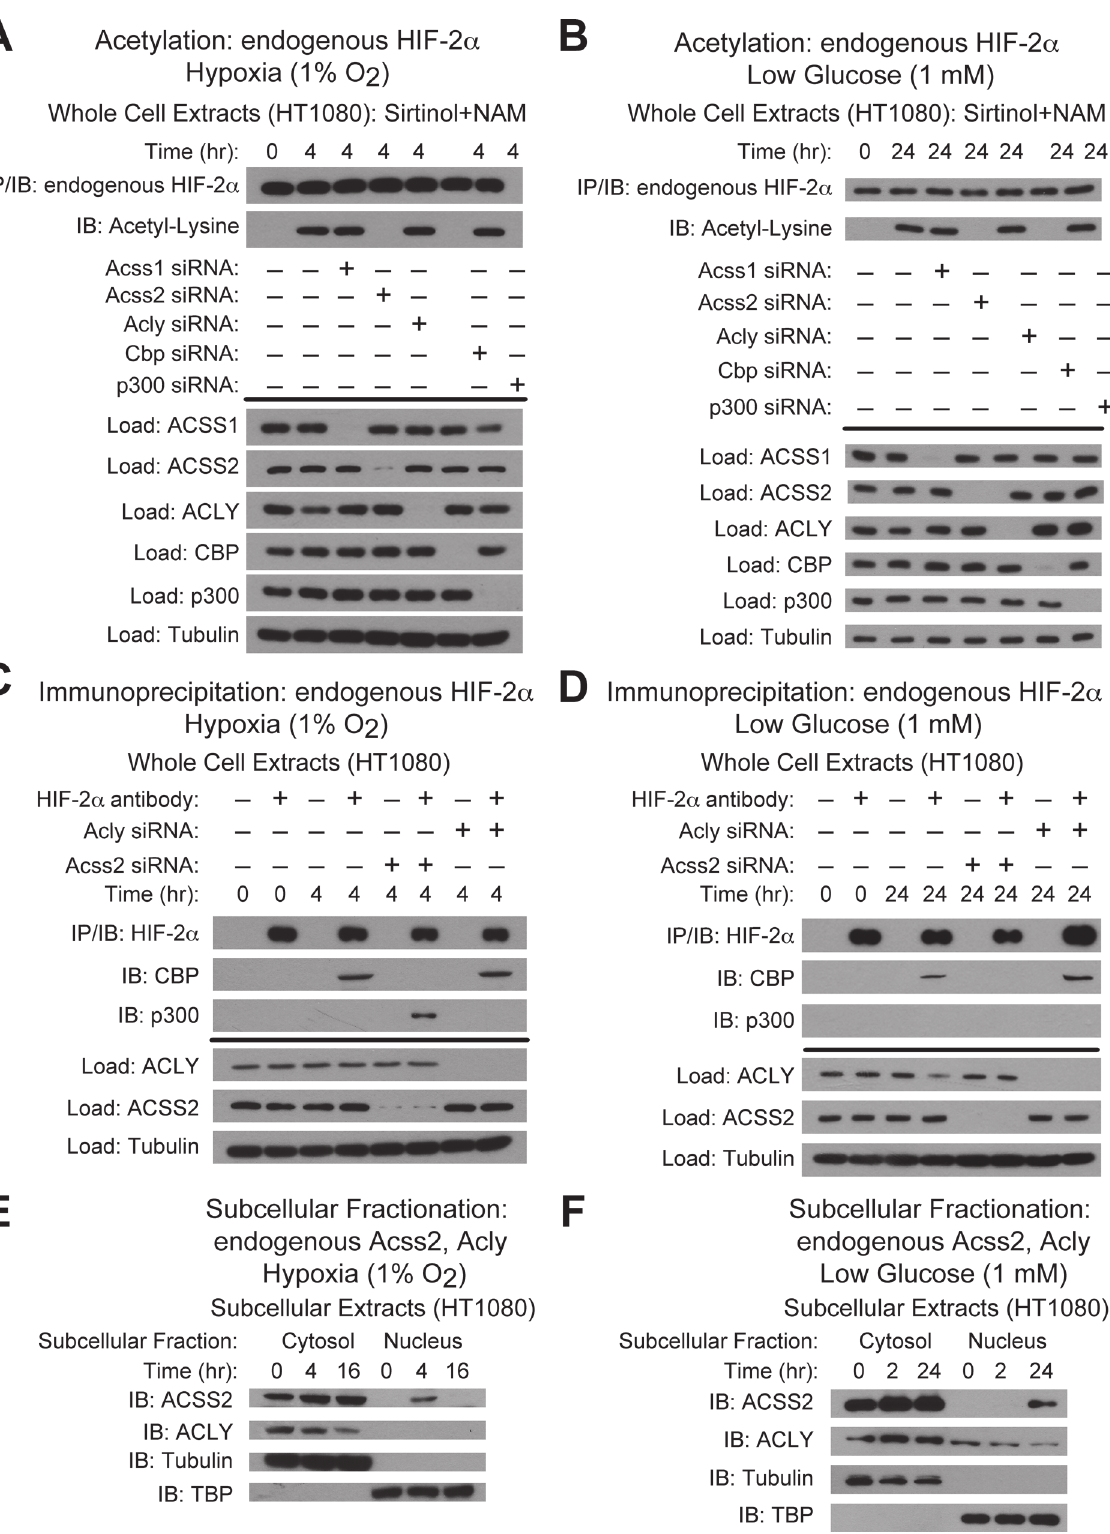
Fig 2. ACSS2 is the molecular mediator of the acetate switch. (A) Acetylation of endogenous HIF-2 α after immunoprecipitation (IP) and detection by immunoblotting (IB) after early (4 hr) hypoxia exposure with pharmacological inhibition of Sirt1 by sirtinol and nicotinamide (NAM). (B) Same as (A)